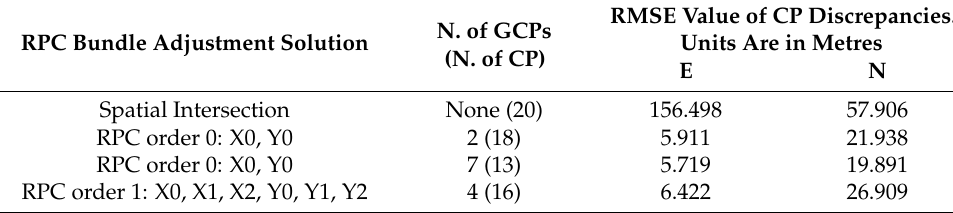
Table A3. Results of RPC bundle adjustment with bias compensation for strip in N-S direction in the left side, Rome test